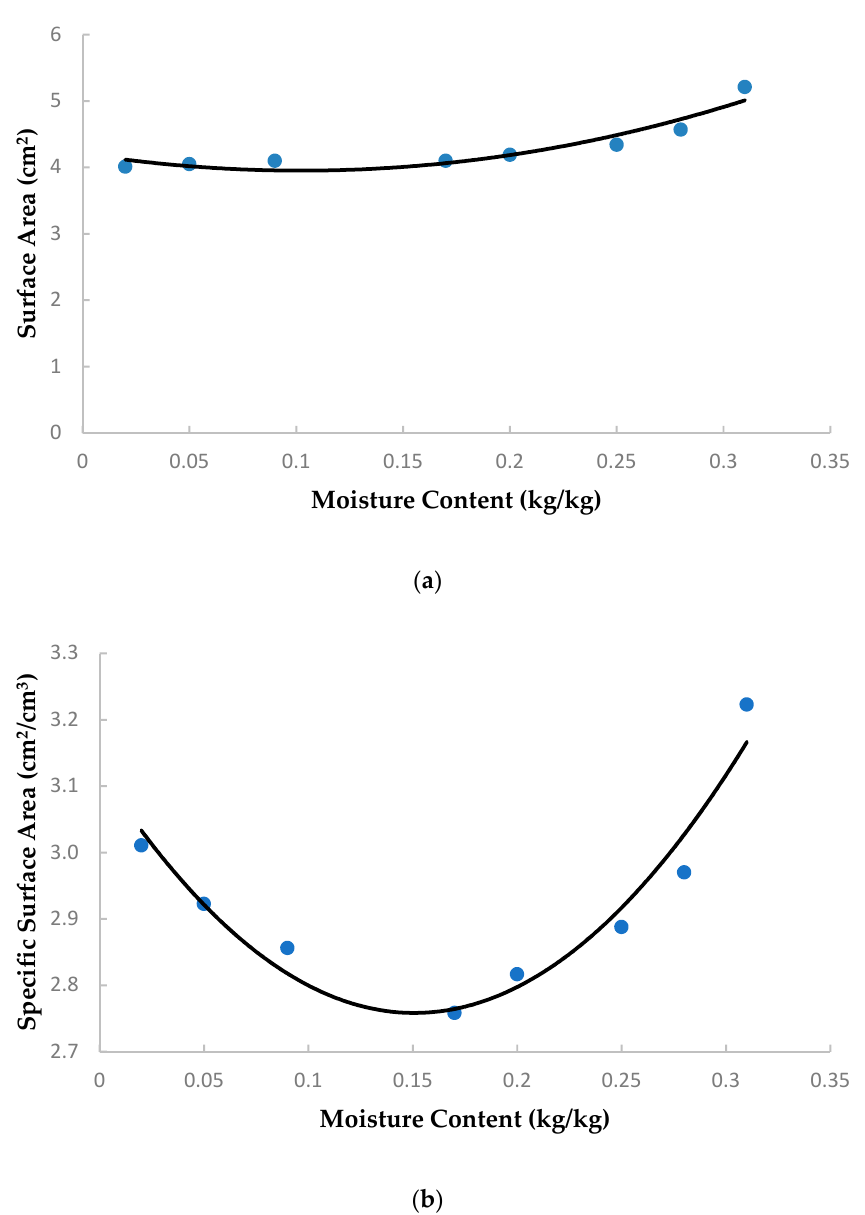
Figure 3. ( a ) Surface area of palm kernel, ( b ) specific surface area of palm kernel at different moisture contents.